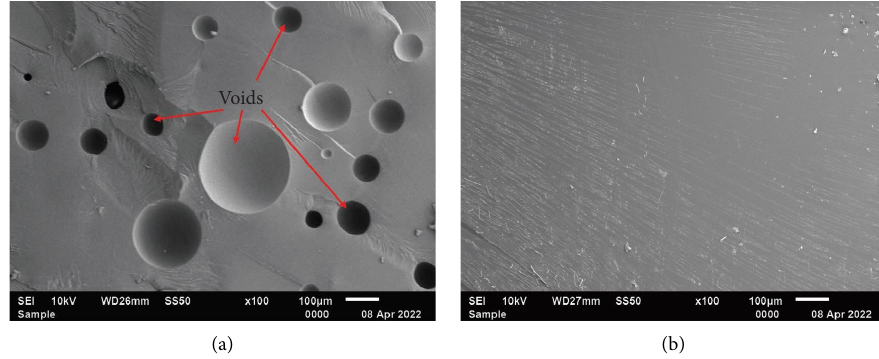
Figure 17: SEM image of epoxy resin samples mixed in air (a) or stirred in vacuum (b).